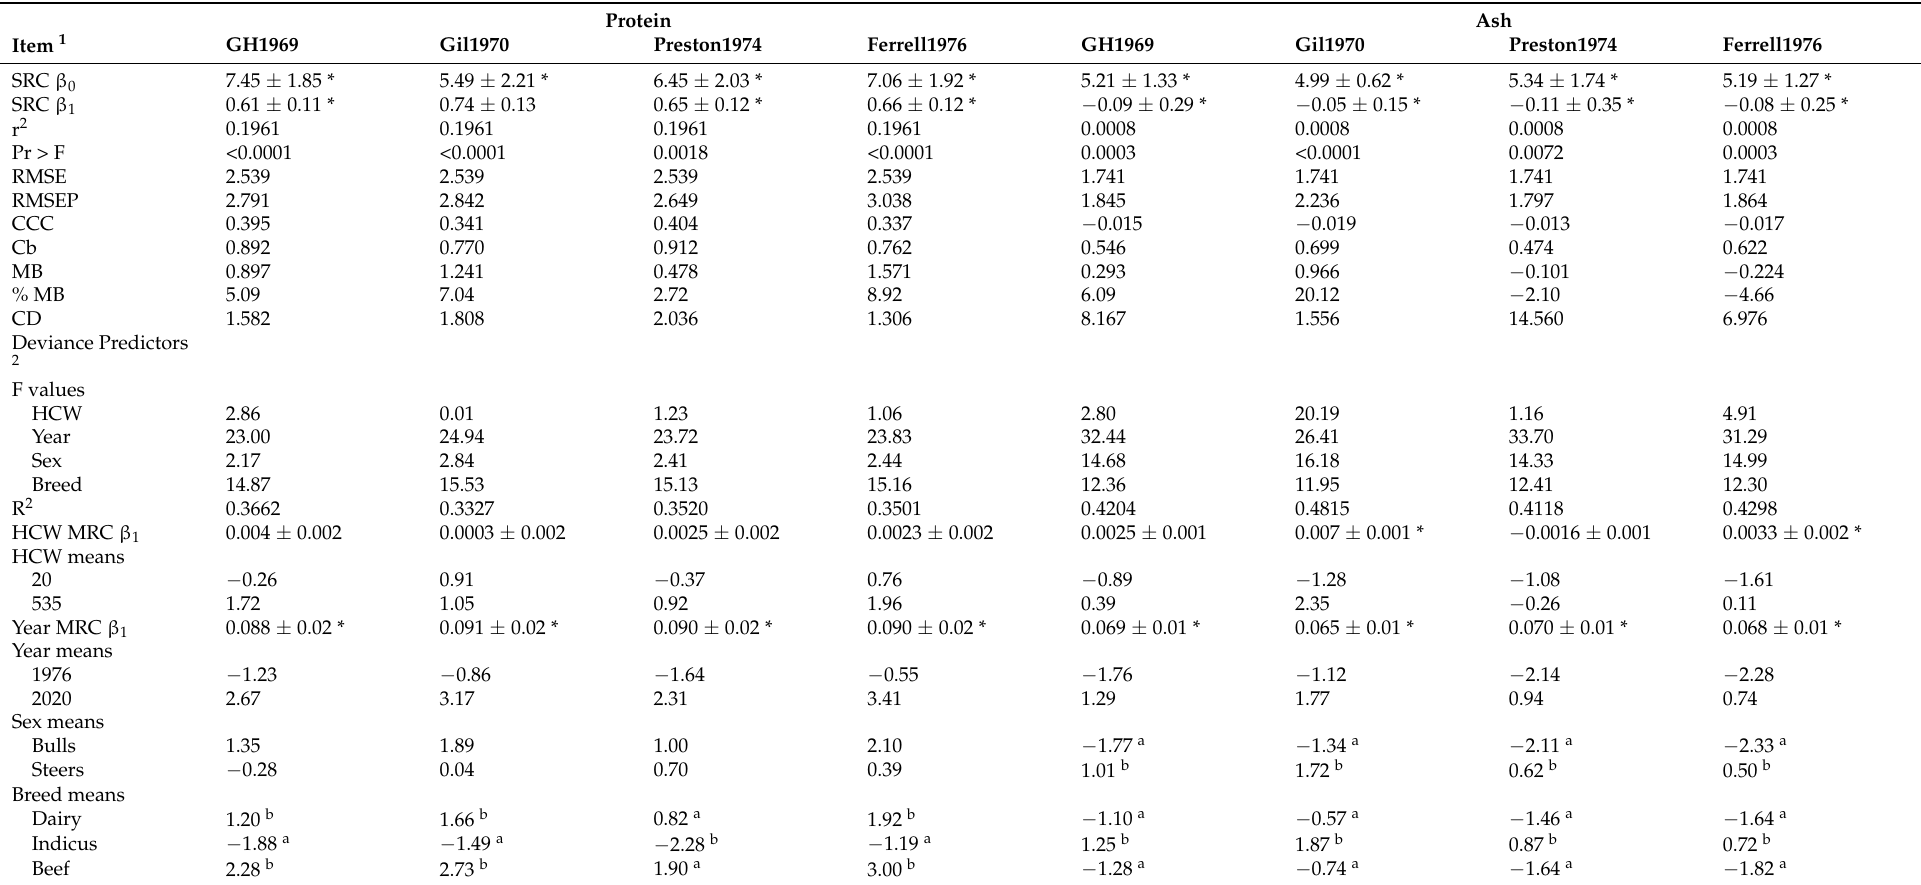
Table 10. Model evaluation of predicting carcass chemical protein and ash assuming carcass water is known, and predictive variables of the deviance between observed and predicted carcass chemical components in the Carcass